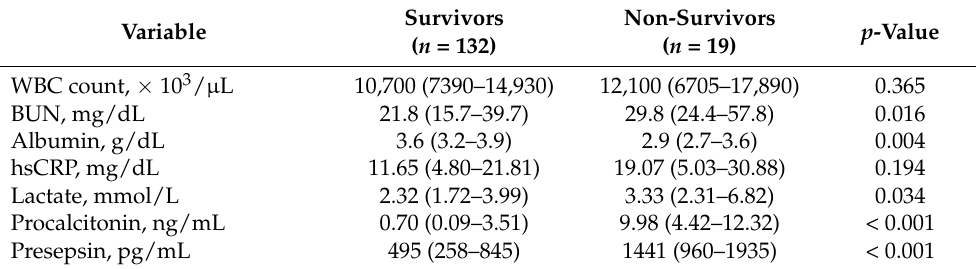
Table 6. Comparison of laboratory results on ED admission between survivors and non-survivors among patients with